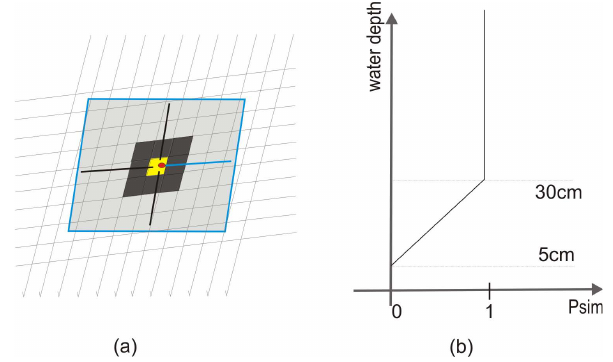
Fig. 7. Illustration of the evaluation of the spatial performance of the model using flood extent maps. (a) Representation of the diked floodplains in the Vietnamese part of the Delta in the model overlain by the flood extent map. Red dot: node that represents the inunda- tion state of the area in the floodplain compartment surrounding the node in the model; yellow pixel: pixel of the extent map matching the node; gray pixels: neighbouring pixels of the extent map used in the performance evaluation. (b) Fuzzy membership function used for the determination of the floodplain compartment nodes as being